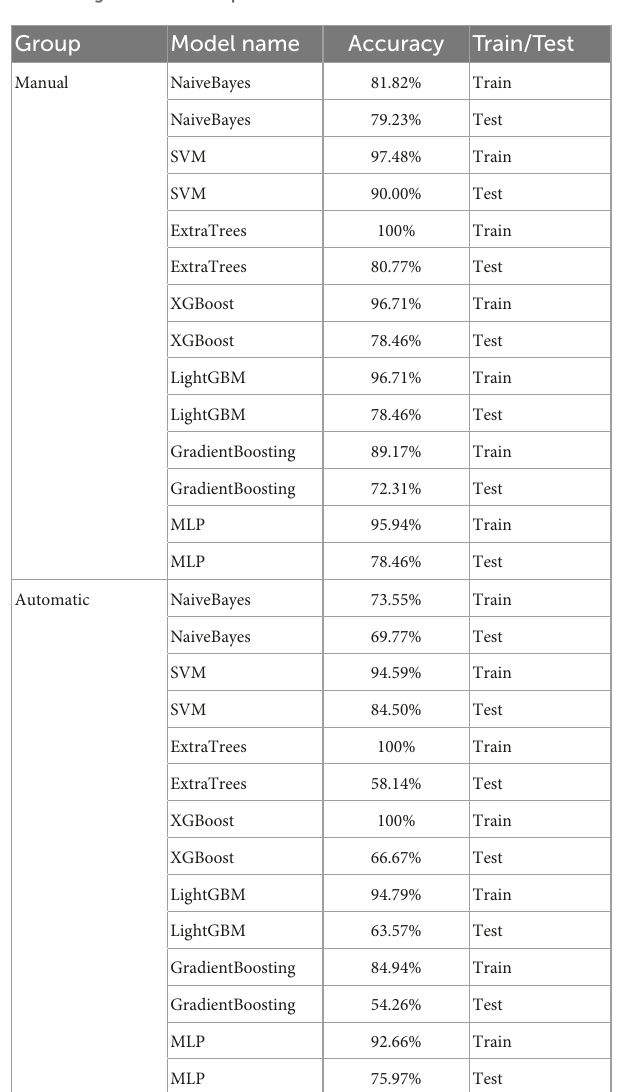
TABLE 1 The accuracy of classification models in the automatic and manual segmentation DTL